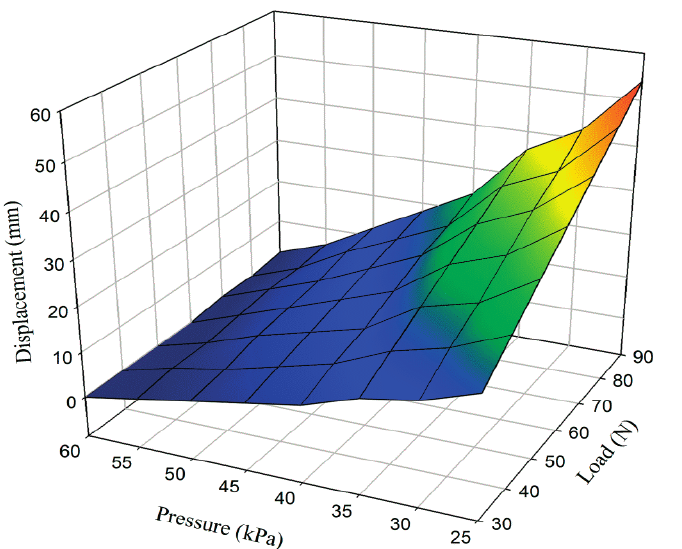
Figure 7. Average values of distances between posterior trims line and liner